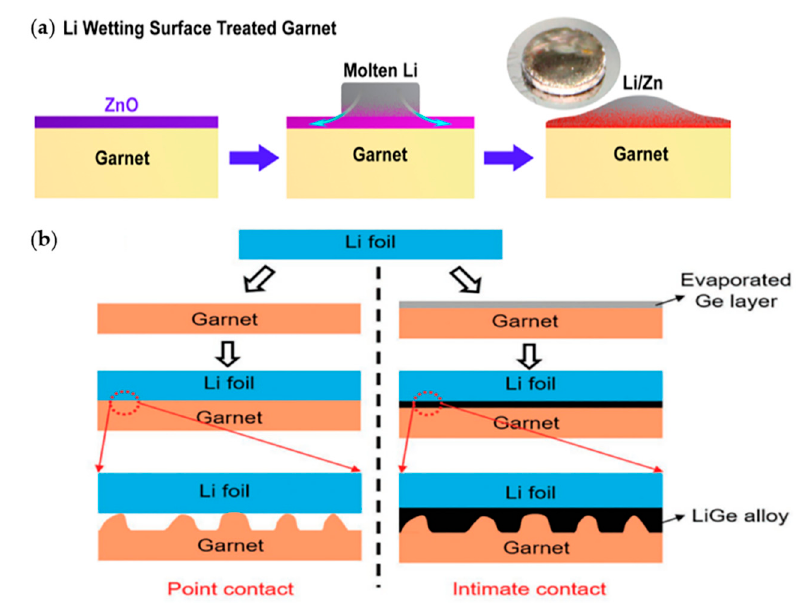
Figure 14. ( a ) ZnO-coated garnet electrolyte. Reprinted with permission from [153]. Copyright (2017) American Chemical Society.; ( b ) Ge-coated garnet electrolyte. Reprinted with permission from [154]. Copyright (2017) John Wiley and Sons.